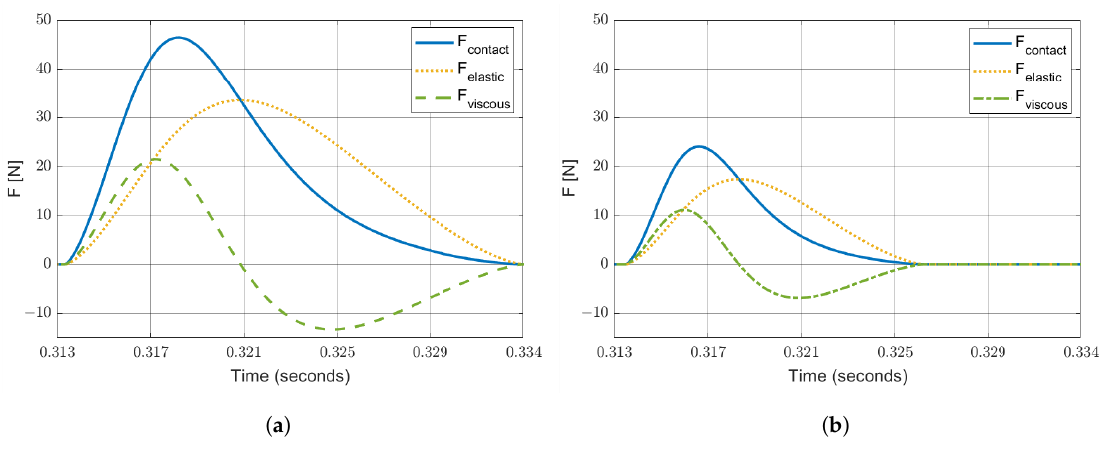
Figure 5. Temporal evolution of contact force for the non-linear model. ( a ) Limit case of Figure 4a; ( b ) limit case of Figure 4b.